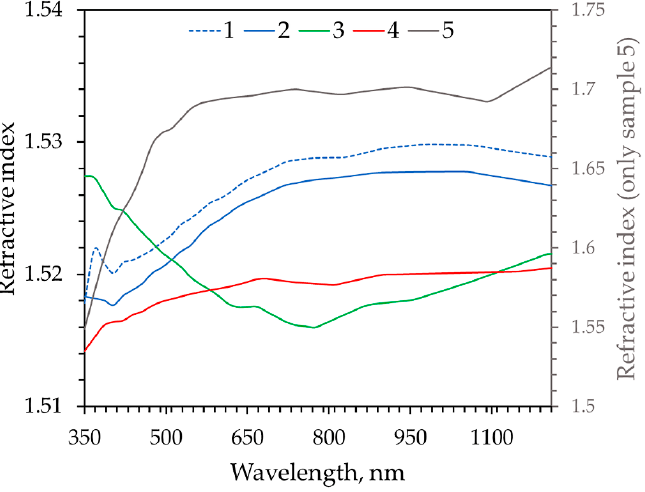
Figure 7. Dispersion of refractive indices of the valve metals functional thin films. For all quasi-ordered samples, the average refractive index is about 1.52 ± 0.01 and remains stable over the analyzed wavelength range under consideration. These values are lower than usual for PAAO, which suggests that porous anodic films with small thick- nesses due to the well-ordered structure of anodic oxides will have a refractive index lower than a transparent substrate, but unlike thicker anodized aluminum coatings, will have good adhesion due to the presence of a sublayer [47–50].